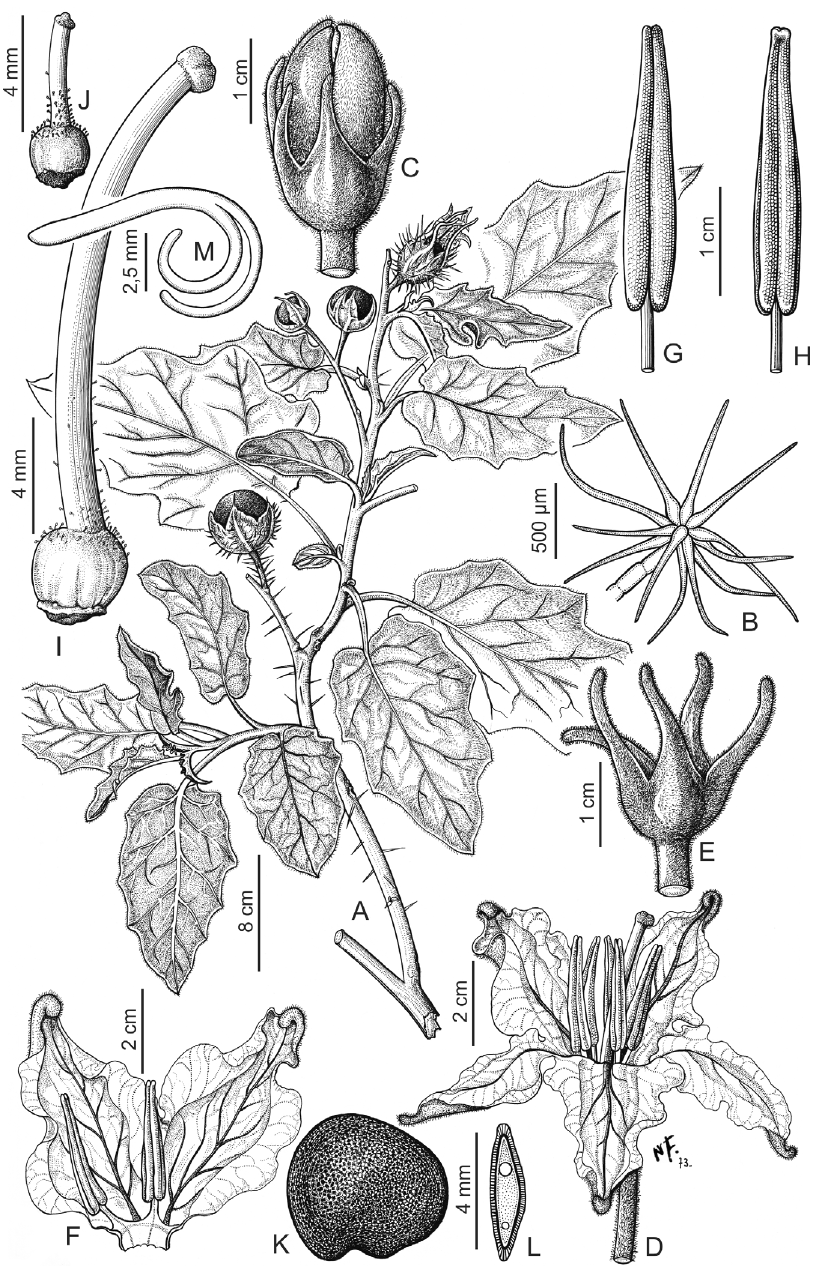
Figure 13. Solanum mortonii Hunz. A Fruiting branch B Stellate trichome of leaf C Floral bud (showing elongate calyx acumens) D Flower E Calyx F Spread corolla G Dorsal view of stamen H Ventral view of stamen I Gynoecium of long-styled flower J Gynoecium of short-styled flower K Seed L Transverse section of seed M Embryo. Drawn by Nidia Flury. A–F, I–L from Hunziker 22764 (CORD) G, H from Hunziker 21869 (CORD). Reproduced with permission from Flora Argentina (Chiarini